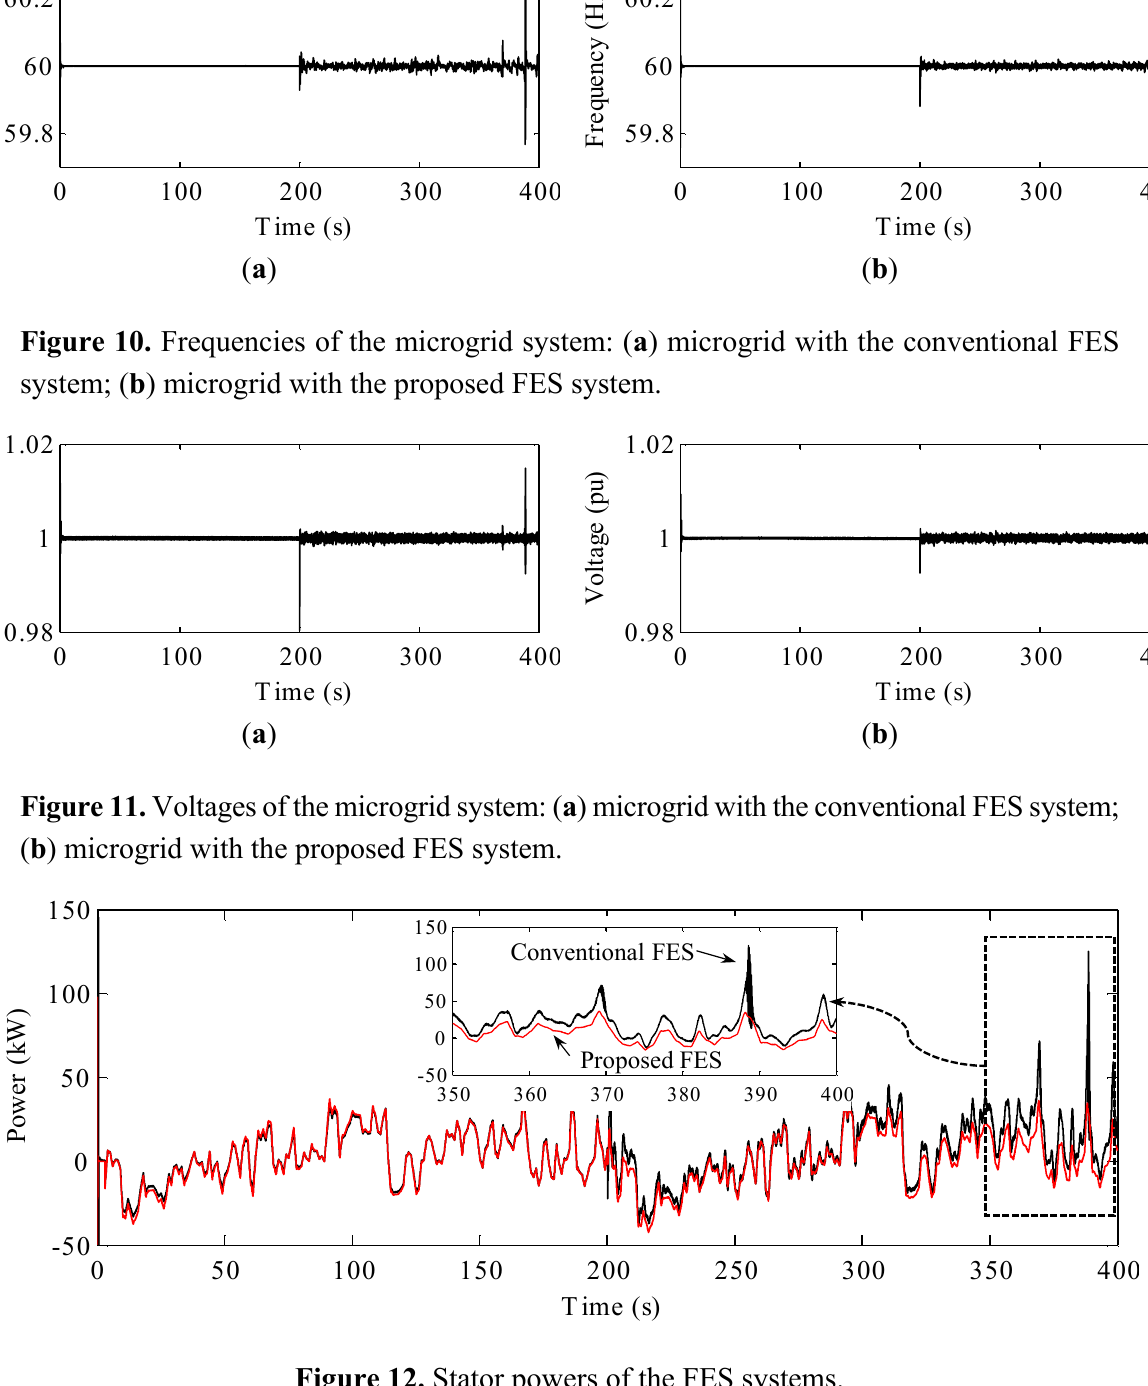
Figure 12. Stator powers of the FES